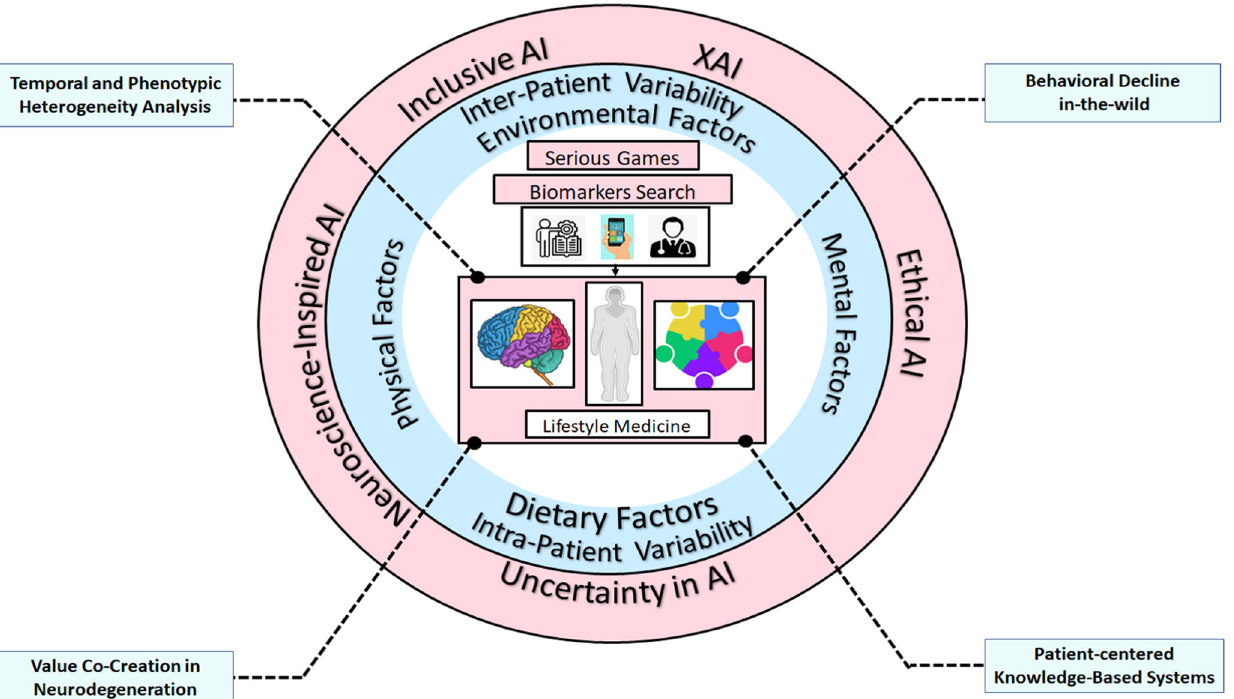
Fig. 1 The taxonomy of explainable digital phenotyping of neurodegenerative diseases. The quanti fi cation of patient-speci fi c subtle behavioral decline at the brain, body and social level is the microsystem of the taxonomy (white). The analysis of the interaction with environmental factors that aid in deciphering inter- and intra-patient variability is the mesosystem of the taxonomy (blue). The co-creation approach by neuroscientists, neurodegenerative disease specialists and bioengineers fosters the creation of a new AI landscape for personalized neurodegenerative disease characterization